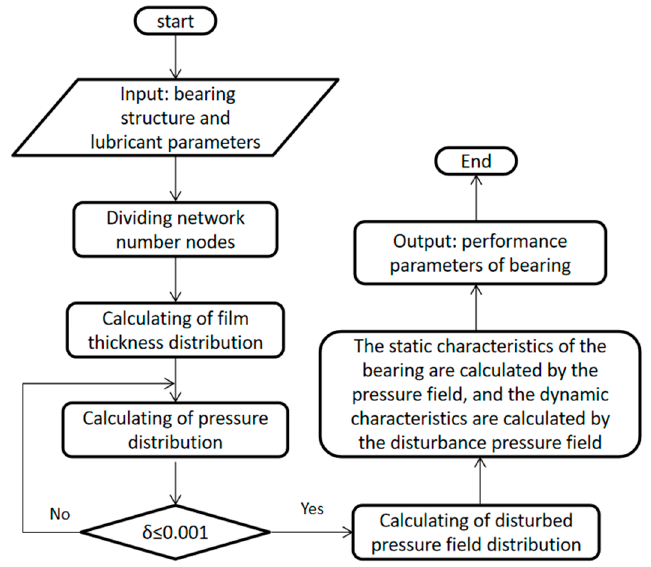
Figure 6. Flowchart of the numerical procedure.